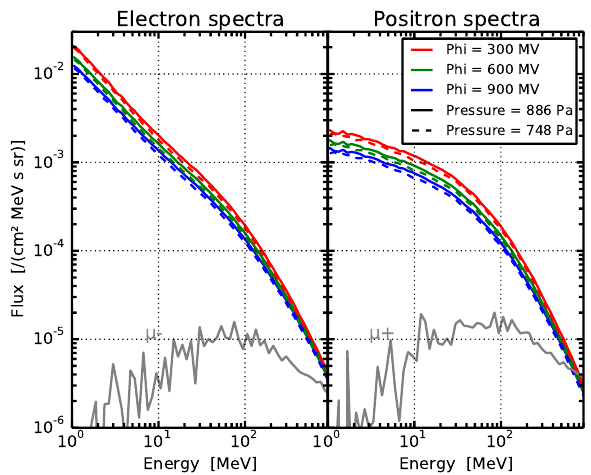
Figure 2. Electron and positron fluxes on the Martian surface cal- culated with Planetocosmics. The fluxes have been calculated for cosmic modulation values of 300 (red), 600 (green), and 900 (blue) MV and for pressure values of 886Pa (solid) and 748Pa (dashed). Muons and antimuons (gray) are shown for reference only (modu- lation potential = 600MV, pressure =